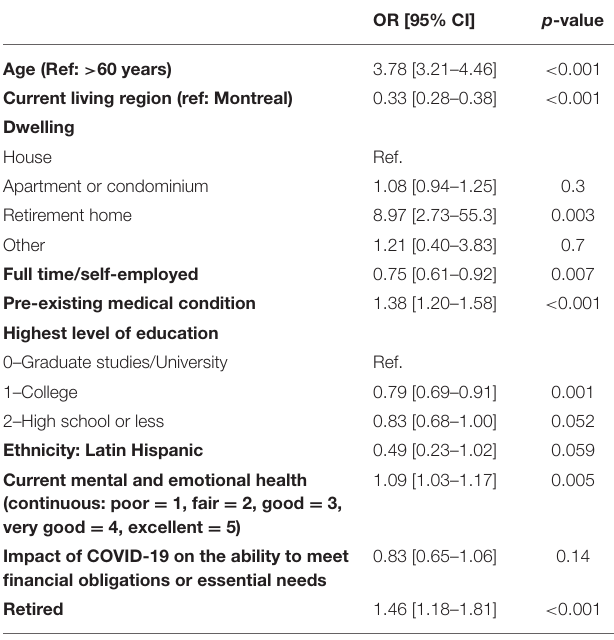
TABLE 1 | Multiple logistic regression for being vaccinated. TABLE 2 | Variables significantly associated with vaccine hesitancy/refusal in univariate